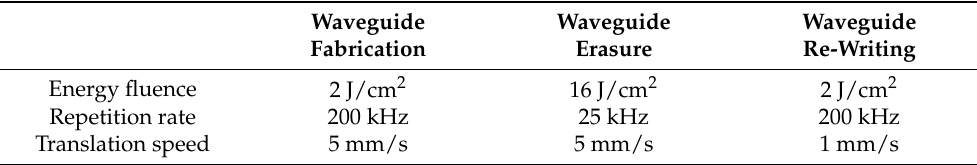
Figure 1. ( a ) Photograph of the as-prepared silver metaphosphate AgPO 3 glass sample; ( b ) SEM image of the as-prepared AgPO 3 glass cross-section (top-view). ( c ) Schematic representation of the experimental apparatus. ( d ) Typical optical absorbance profile and XRD pattern of AgPO 3 glass. The experimental setup for the direct laser inscription of the waveguides is shown in Figure 1c. The laser source used was an Yb: KGW femtosecond laser (Pharos femtosecond) from Light Conversion, with a maximum pulse energy of 1.5 mJ and a maximum laser power of 1.5 W at 1 kHz repetition rate. The fs laser was producing polarized optical pulses of 170 fs, center emission wavelength at 1026 nm and tunable repetition rate up to 200 kHz. The laser beam pulses were focused on the phosphate glass sample using either a plano-convex lens or a 10 × Mitutoyo Plan apochromatic infinity corrected objective lens. The plano-convex lens was able to create a Gaussian ~60 µ m diameter beam spot at 200 mm focal length, and the objective lens at 20 mm focal length resulted in a much smaller in diameter ~10 µ m beam spot. Both spots were measured by a CMOS camera at 1/e 2 within the Rayleigh range of the focal plane. To assist in distinguishing the two pathways employed each time throughout the text, we will use the terms W-Lens for the plano-convex lens, and W-Obj for the Mitutoyo × 10 objective lens. Table 1 summarizes the employed laser irradiation parameters for the waveguide fabrication, erase, and re-write processes. Table 1. Summary of employed laser irradiation conditions for the waveguide fabrication, erase, and re-write